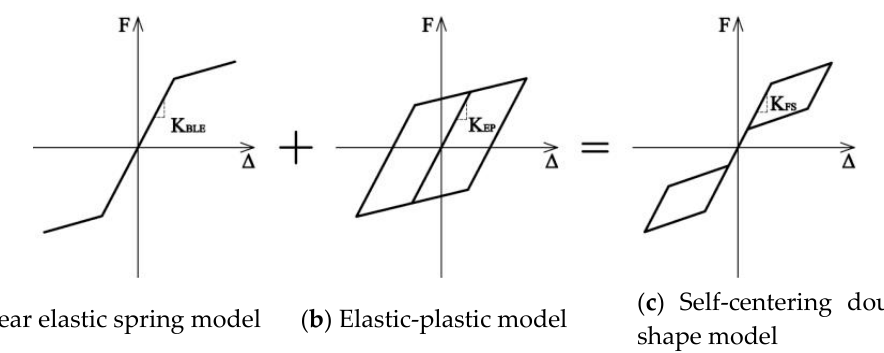
Figure 6. Theoretical hysteretic model of the novel connection.